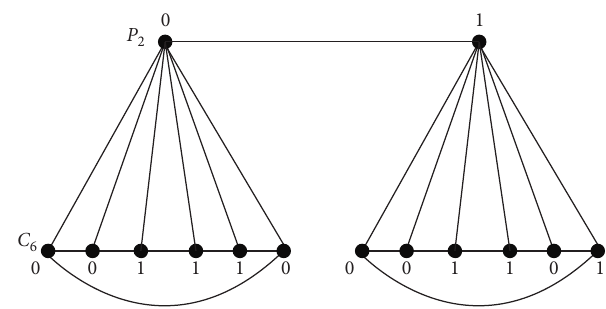
Figure 23: Logical labeling of P